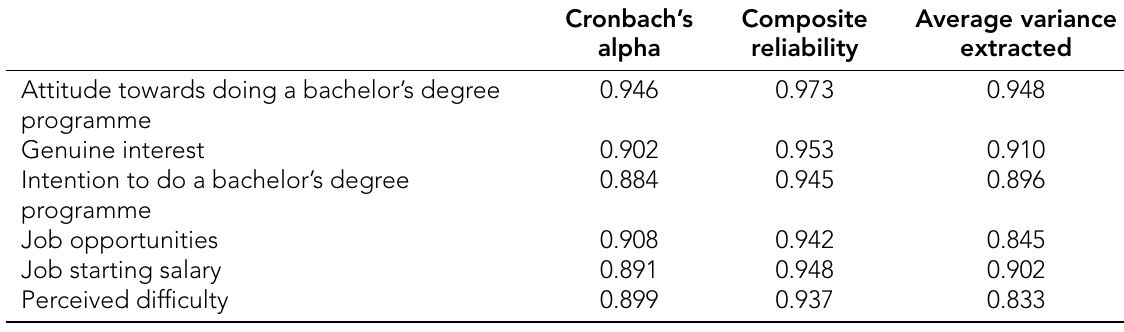
Table 4. Cronbach’s alpha, composite reliability and average variance extracted (Source: Authors,